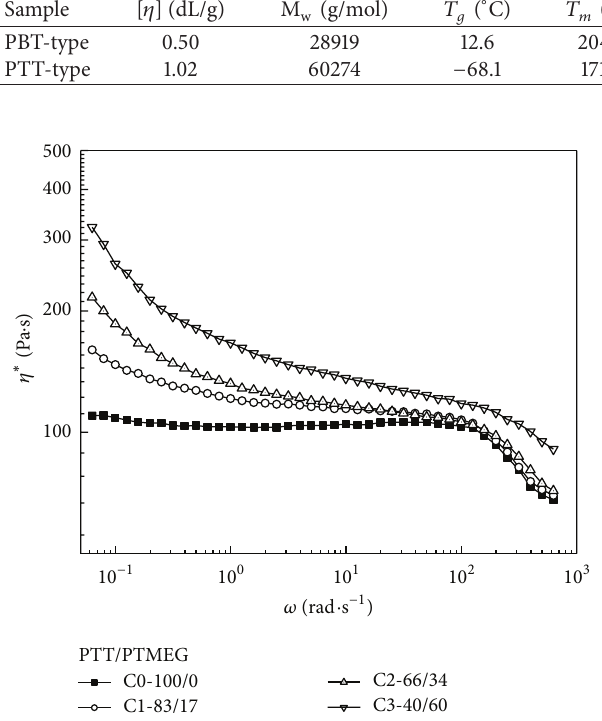
Figure 8: Curves of 𝜂 ∗ versus 𝜔 of the various copolymers.